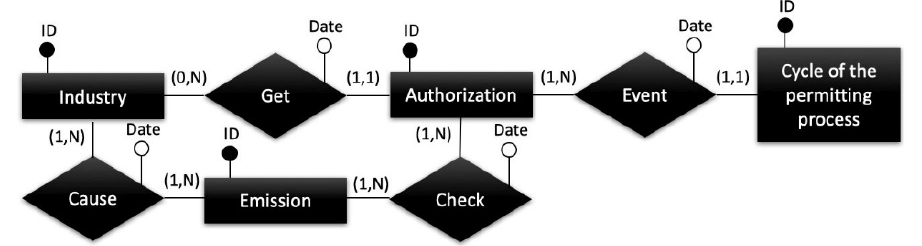
Figure 3. Part of the database schema with ER model.